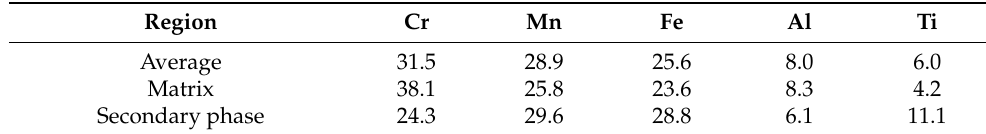
Table 2. Average composition (at.%) of the as ‐ cast Al 10 Cr 30 Fe 25 Mn 30 Ti 5 HEA and compositions of the matrix and secondary phase particles.